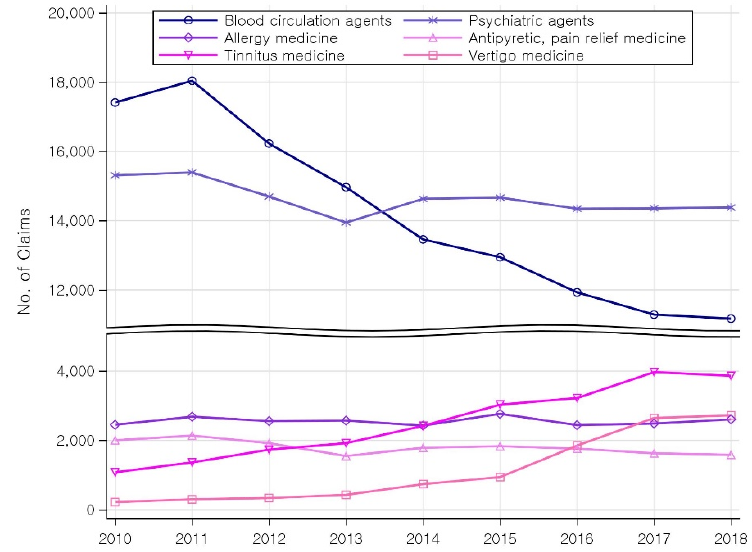
Figure 3. Yearly trend in major drug